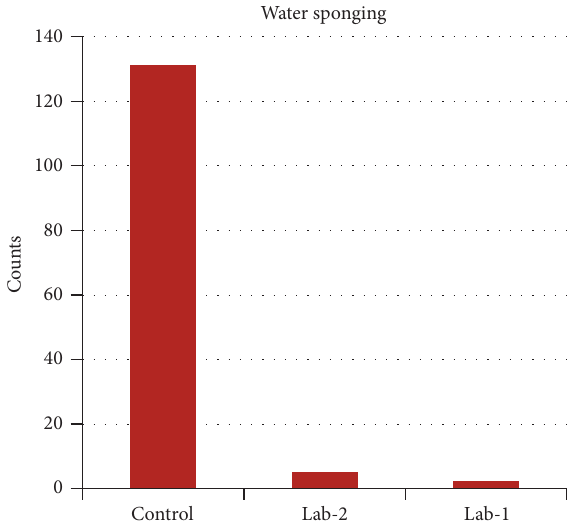
Figure 8: Total count of baby water-sponging events during the months of September, October, March, and April. There was only one sponging event in Lab-2 and none in Lab-1 during the September-October seasonal segment. Baby sponging occurred regularly in the control during both seasons. Table 1: Heat exchanger temperatures during operation. Average temperature 12 noon 3 pm 6 pm